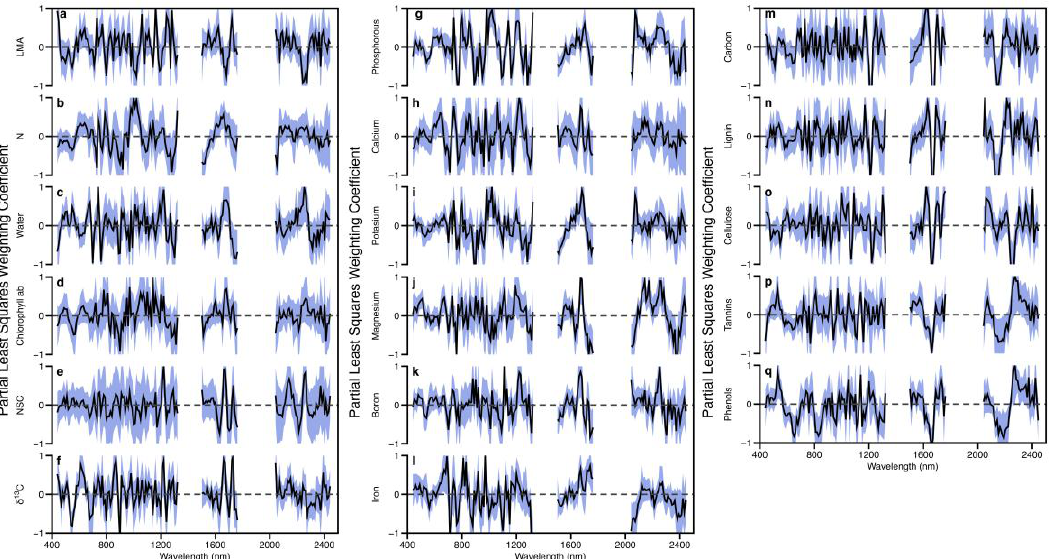
Figure 5. Mean and standard deviation of standardized spectral weighting vectors for PLSR chemometric results for models reported on in Table 2 and Table S4. Subfigures show ( a ) leaf mass per area (LMA); ( b ) nitrogen; ( c ) leaf water; ( d ) chlorophyll ab; ( e ) nonstructural carbohydrates (NSC); ( f ) δ 13 C; ( g ) phosphorous; ( h ) calcium; ( i ) potassium; ( j ) magnesium; ( k ) boron; ( l ) iron; ( m ) calcium;